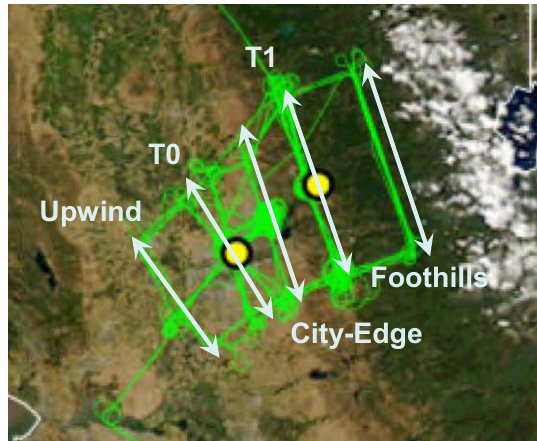
Table 1. Flights used in